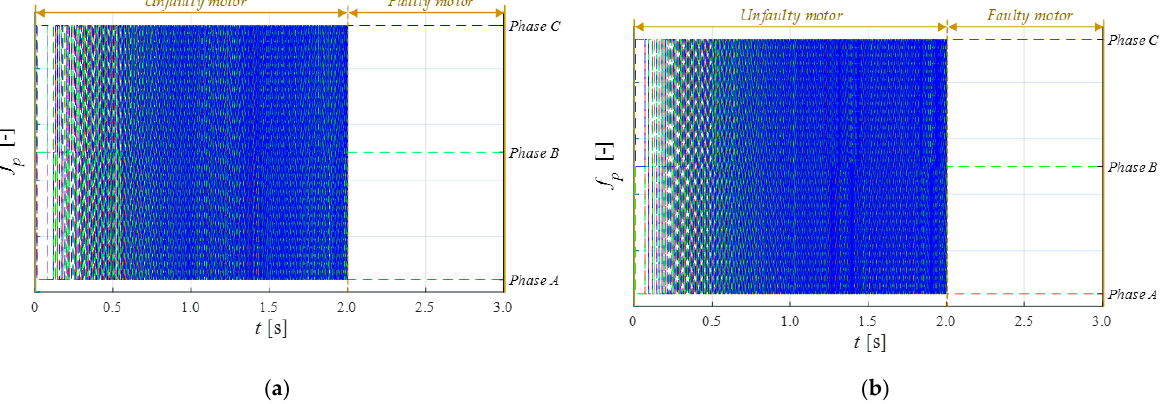
Figure 17. Waveforms of the failure index f p for the operating frequency f s = 100 Hz, T L ≈ 0: scalar control ( a ); field-oriented control ( b ); an example of the inter-turn short-circuit in the phase A , N sf = 1.